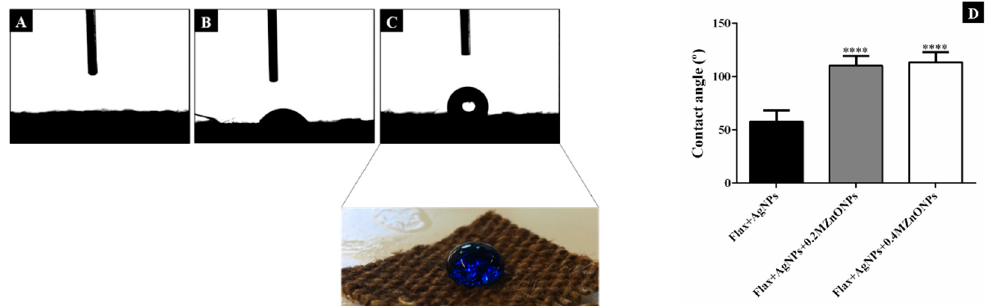
Figure 10. Representative images of water contact angle (WCA) of untreated flax ( A ), flax + AgNPs ( B ) and flax + AgNPs + 0.4 MZnONPs ( C ). Comparison between the WCA values ( D ). Values are represented by mean ± SD. Flax + AgNPs vs. flax + AgNPs + ZnONPs: ****: p < 0.0001.